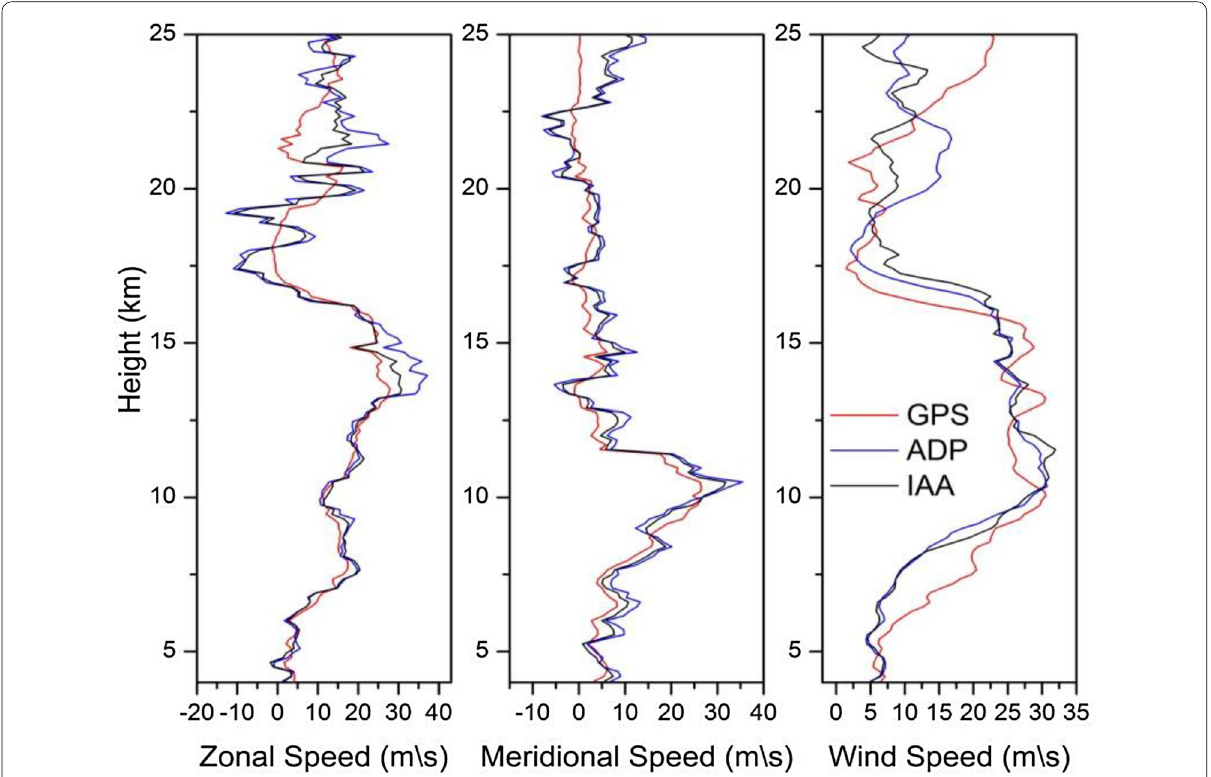
Fig. 7 Zonal, Meridional and Wind Speed for February 9, 2015 data using ADP, IAA and GPS